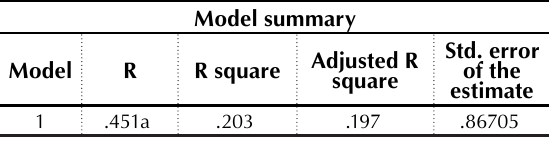
Table 8. Regression analysis between social